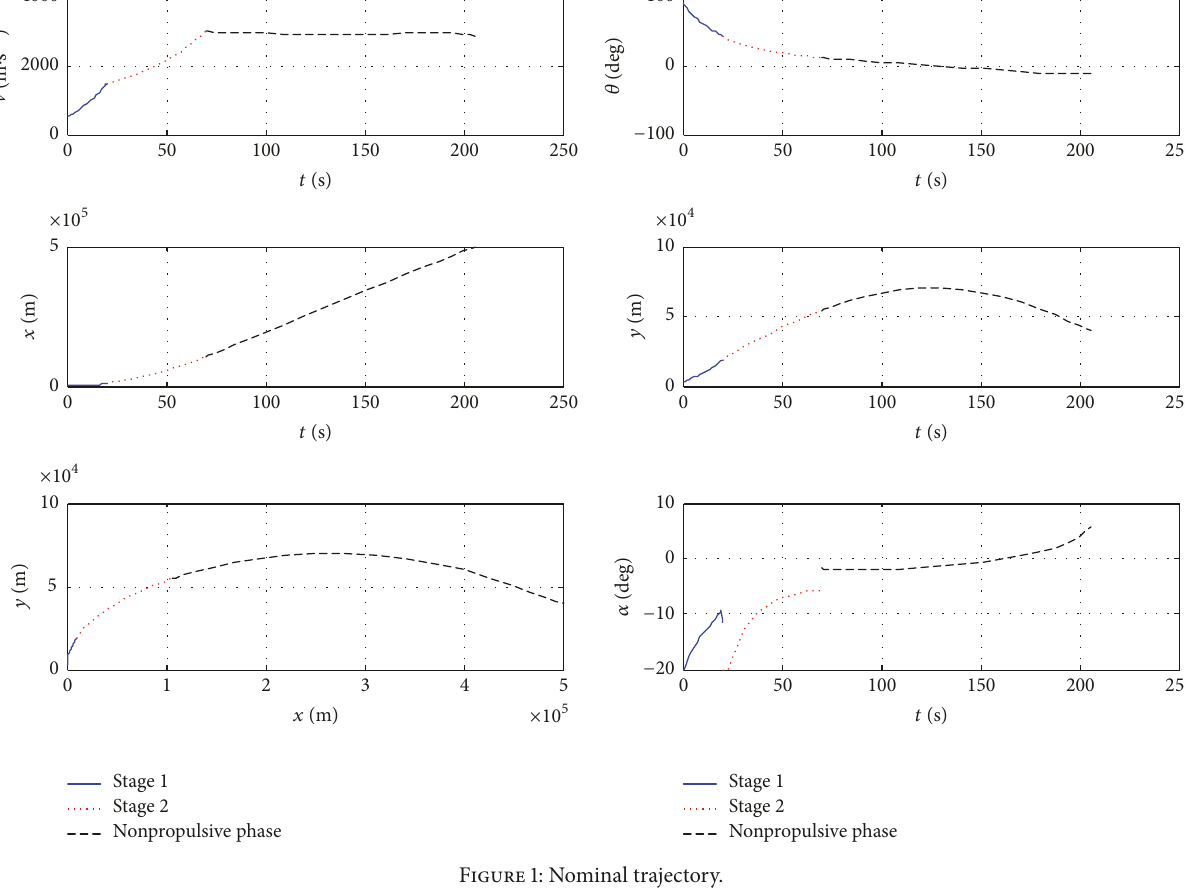
Figure 1: Nominal